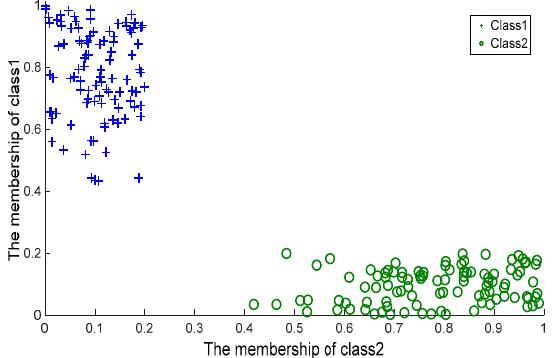
Figure 4. Characterized Support Vector Hyperspheres: membership values.